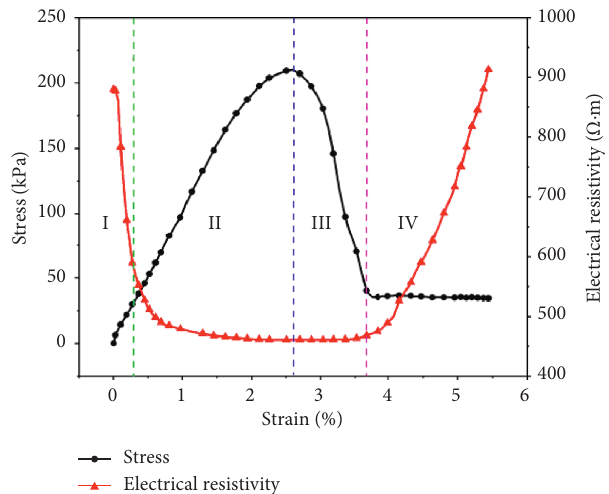
Figure 7: Strain-stress-electric resistivity curve of